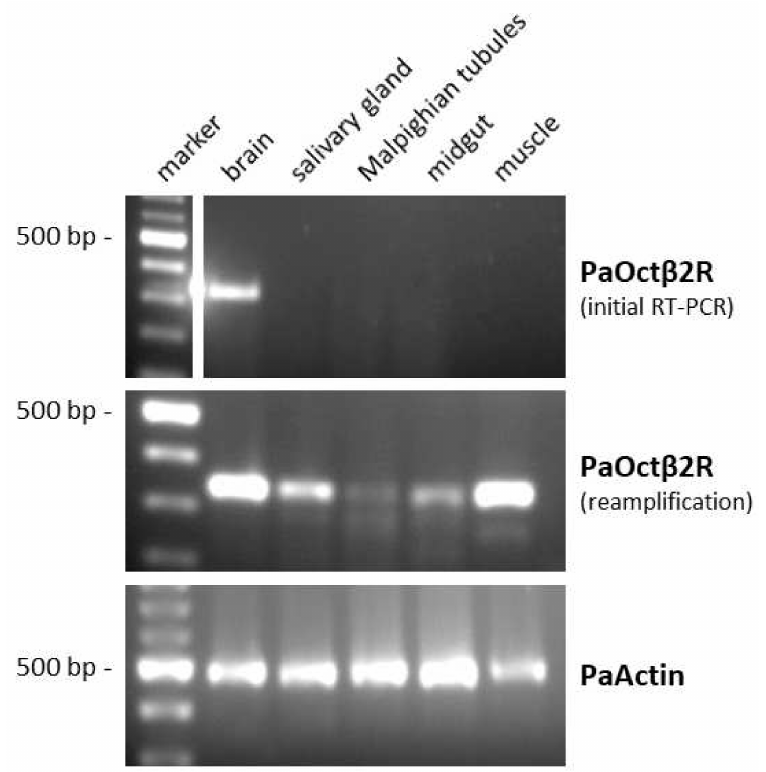
Figure 3. Tissue distribution of PaOct β 2R mRNA. A 100 bp DNA ladder is shown on the left. Detection of PCR products amplified on total RNA isolated from brain, salivary glands, Malpighian tubules, midgut, and leg muscle. Amplification failed when samples were digested with an RNAse cocktail prior to RT-PCR (data not shown). The lower panel shows RT-PCR products amplified with actin-specific primers (Accession No. AY116670) as a